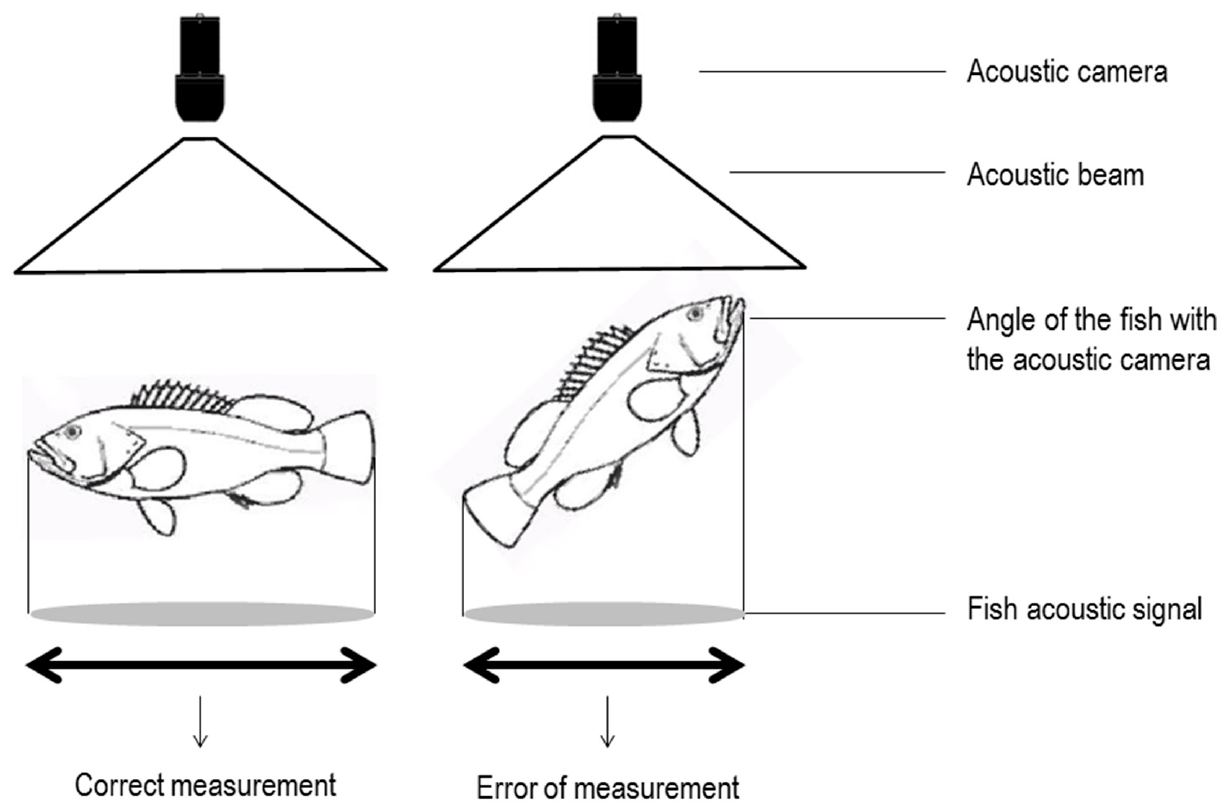
Figure 3. Scheme of measurement error of fish with an acoustic camera.